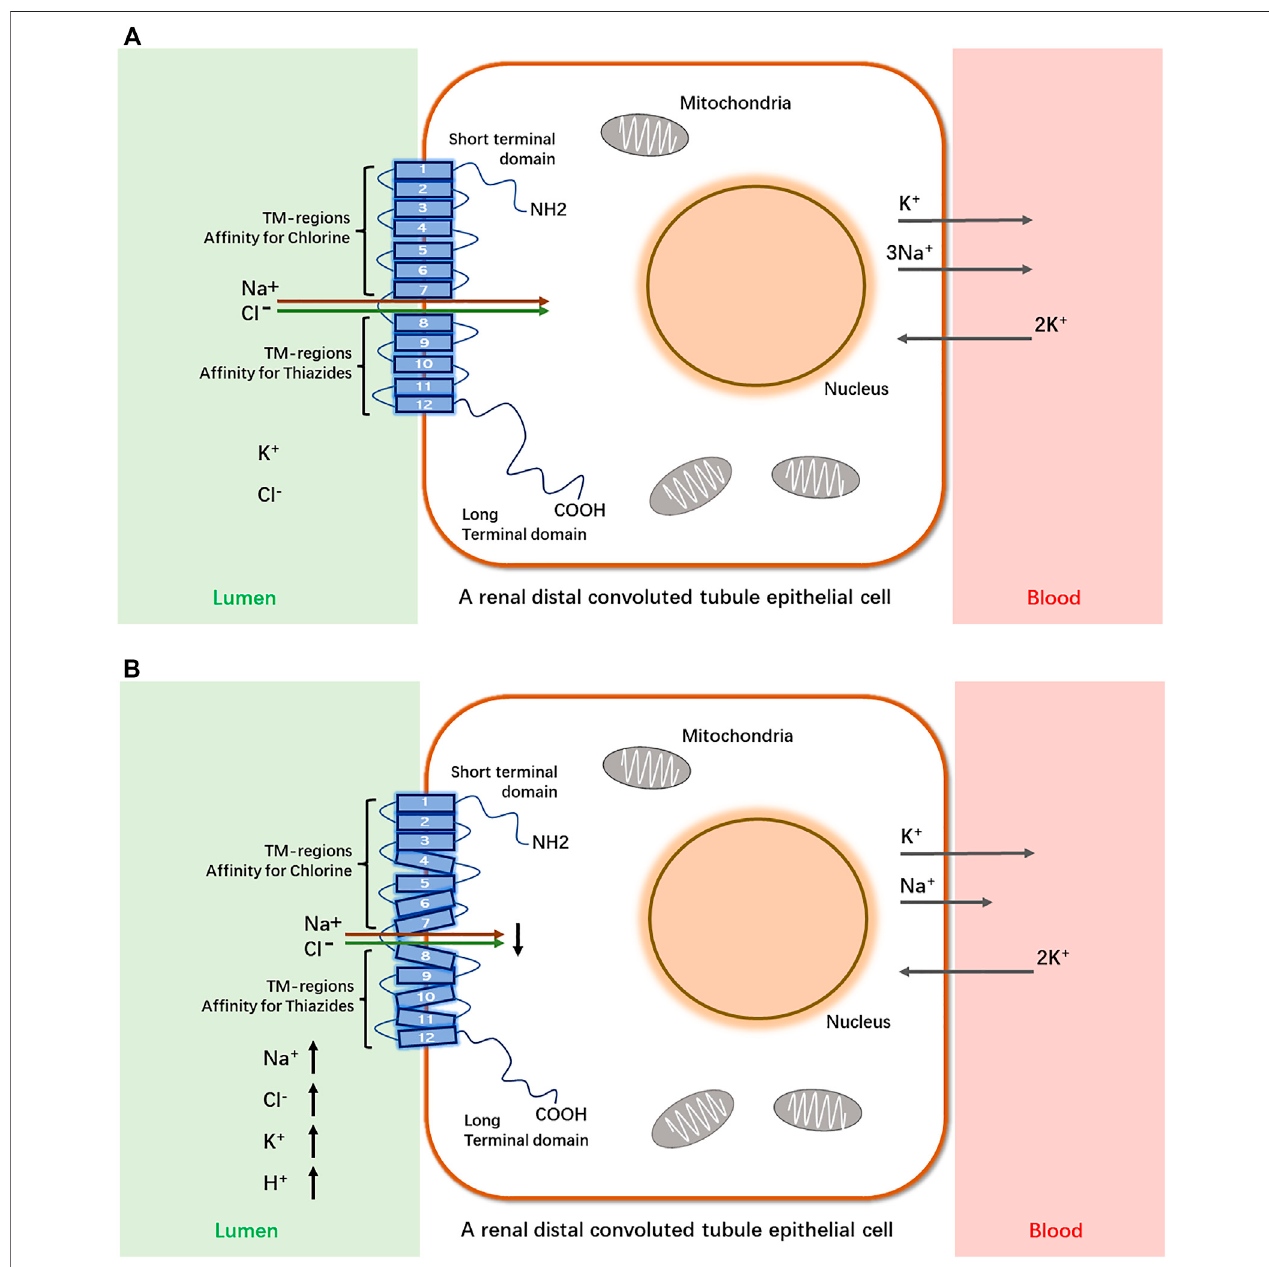
FIGURE 1 | A schematic diagram of SLC12A3 as a transmembrane protein to transport Na + and Cl − from extra- to intra-cellular luminal sides in a renal distal convoluted tubule epithelial cell and its dysfunction in Gitelman syndrome. SLC12A3 is a protein composed of cytoplasmic topological domains and helical transmembraneregionsand fl ankedbyashortamino-terminaldomain(NH2)andalongcarboxyterminaldomain(COOH). (A) Inheathysubjects,mostoftheNa + andCl − in distal convoluted tubule (DCT) of kidneys is reabsorbed by this protein. (B) In individuals with Gitelman syndrome, the dysfunction of SLC12A3 by inactivating mutationsresultsindecreasedreabsorptionofNa + andCl − inDCT.Asaheterotrimer,sodiumchannel epithelial1subunitsalpha, beta,andgamma(SCNN1A,Band G) in the connecting tubule (CNT) and cortical collecting duct (CCD) function with co-reabsorption of Na + . While SLC12A3 is dysfunctional, SCNN1 (also known as ENaC) activity is compensatory increased, resulting in a greater tubular secretion of K + and other ions (Mg 2+ and Na + ) (Colussi et al., 1997).